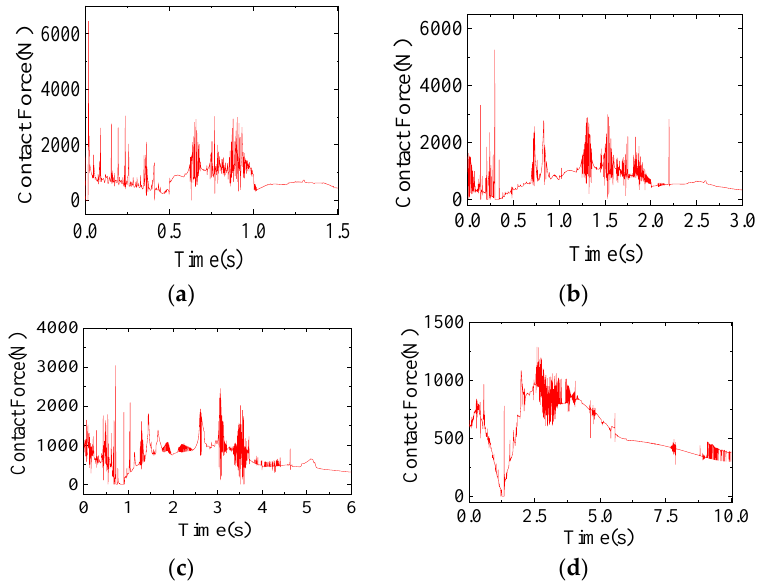
Figure 10. The end contact force change curve of the joint with gap at different speeds: ( a ) Velocity_1; ( b ) Velocity_2; ( c ) Velocity_3; ( d ) Velocity_4.